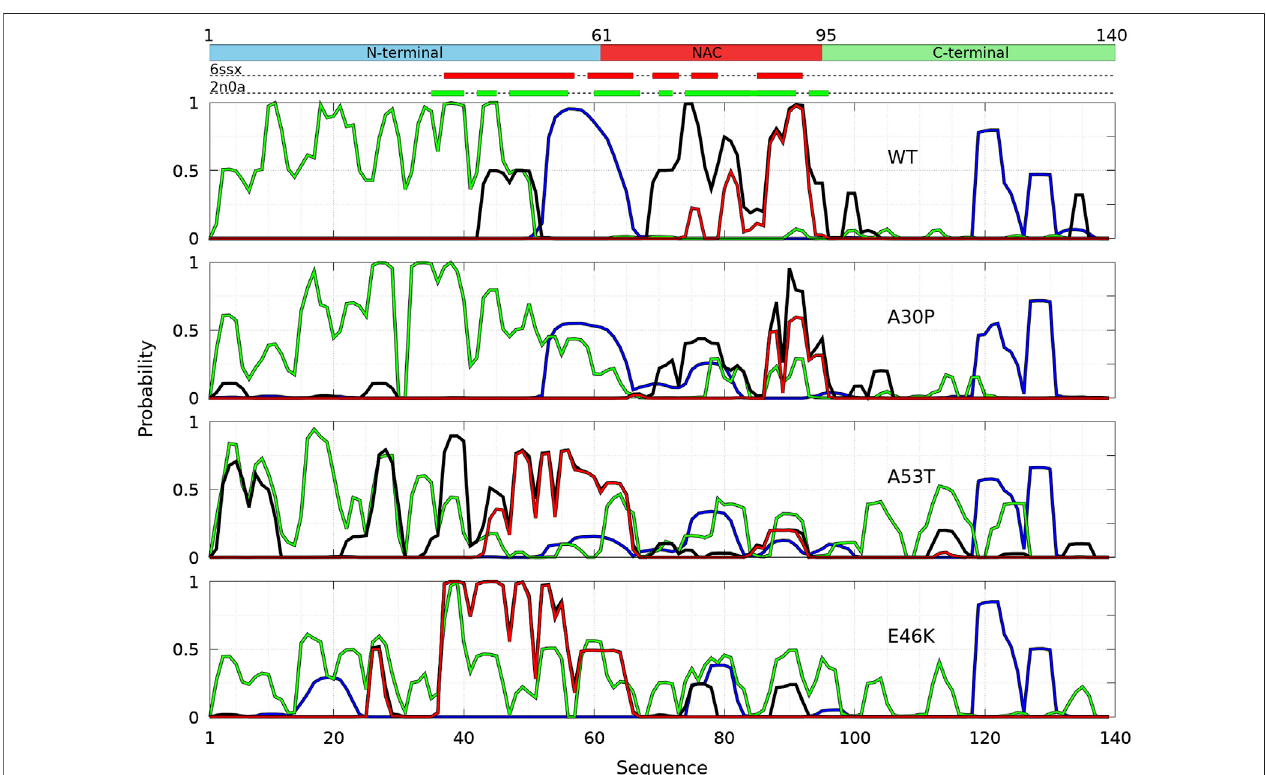
FIGURE 8 | Analysis of the secondary structures in the sub-ensemble of α -syn dimers with native fi bril-type contacts found in molecular dynamics simulations for theWT andthemutantsat 300and310 K.Probabilitiesfor eachresiduetopertain toan α -helix (blue),toanintra-molecular β -sheet (green), toanintermolecular β -sheet (black), and to a native intermolecular β -sheet fi bril type